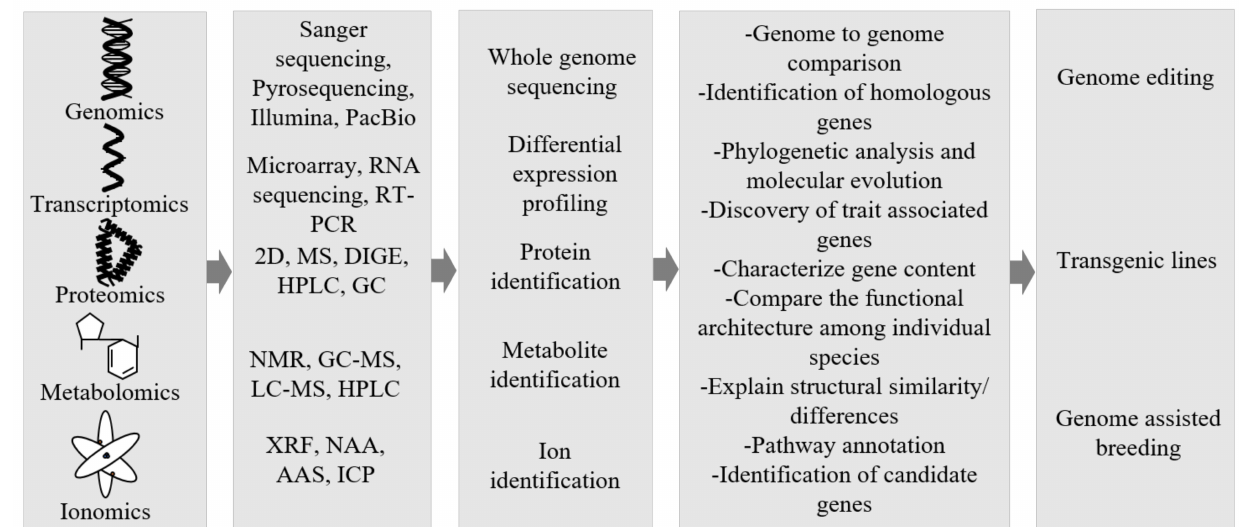
Figure 2. Multi-omics approaches to improve traditional food plants. Candidate genes governing important traits can be identified by combining the data from genomics, transcriptomics, proteomics, metabolomics and ionomics. Manipulations of candidate genes by various techniques to generate improved varieties [31,245,261].